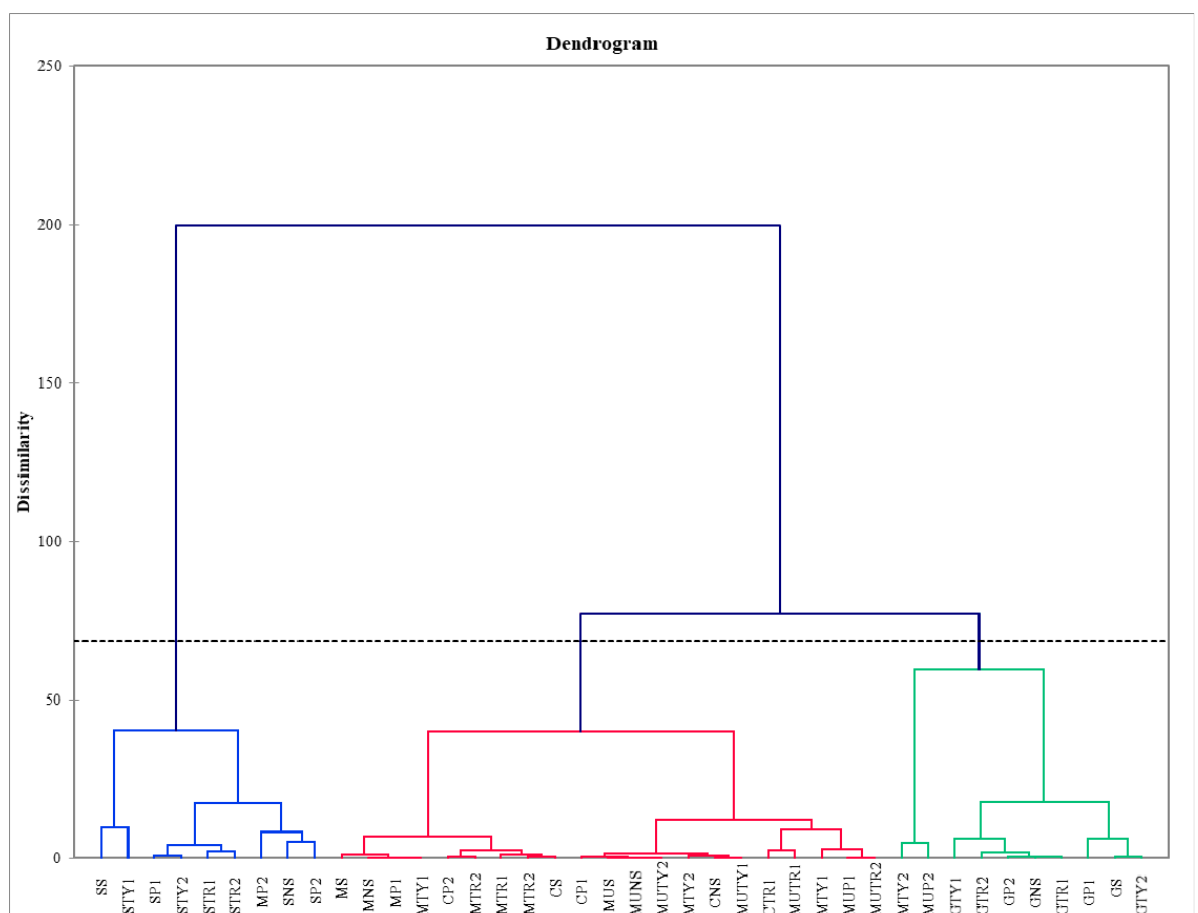
Figure 4. Hierarchical clustering analysis (HCA) of total amount of flavonoids in the chemical composition of different varieties of mint sprayed with different amino acids.